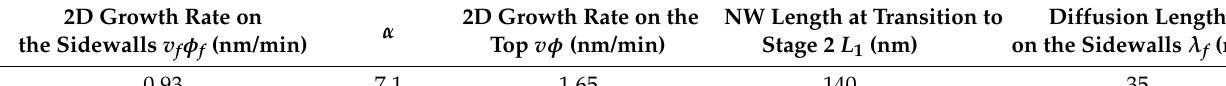
Table 2. Fitting parameters for self-induced GaN NWs grown by MBE.